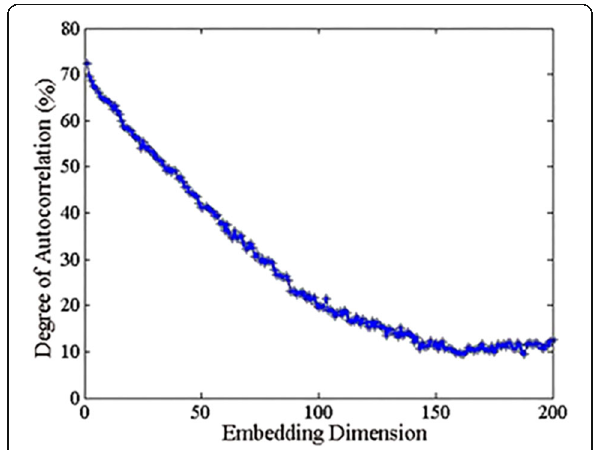
Fig. 2 Autocorrelation of the wind speed data